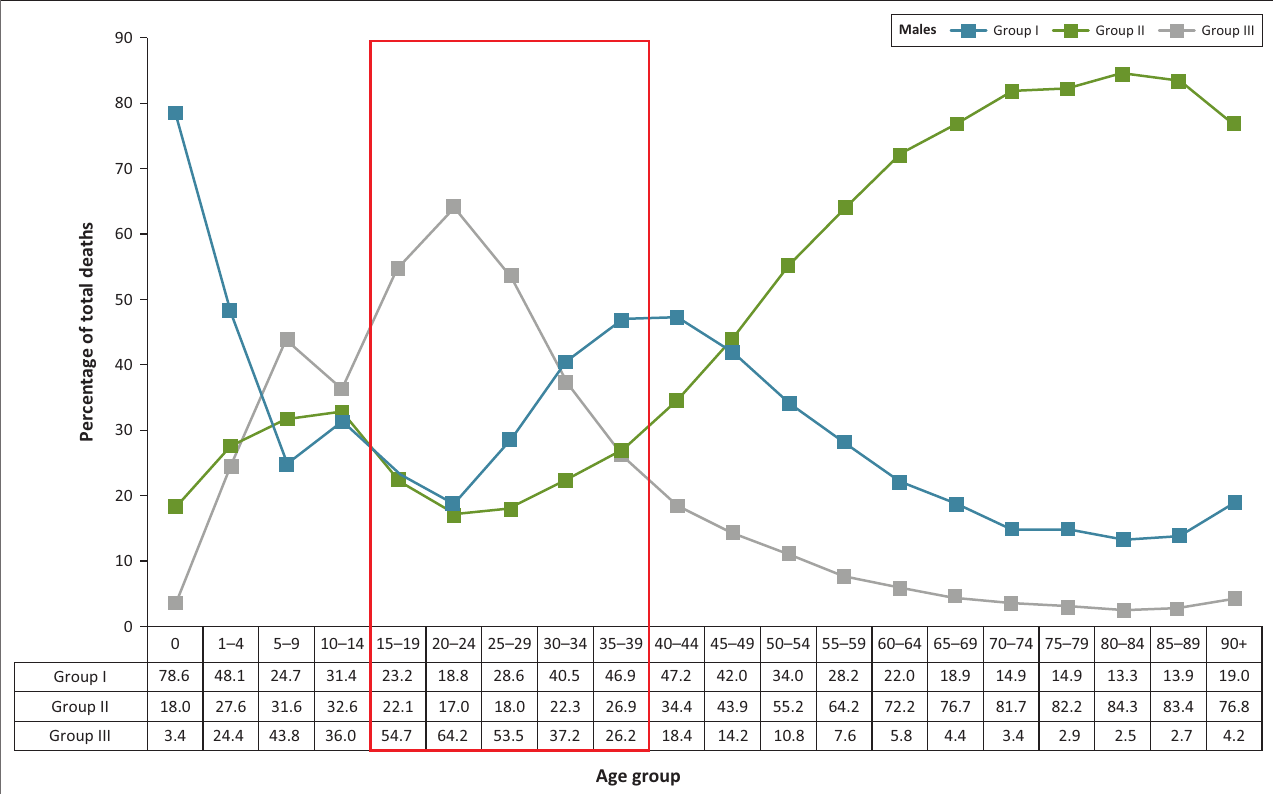
FIGURE 2: Percentage of deaths due to communicable diseases (group I), noncommunicable diseases (group II) and injuries (group III) by gender and age group in South Africa, 2017 (redistributed unknown age and ill-defined diseases R00–R99 proportionately to causes in group I and group